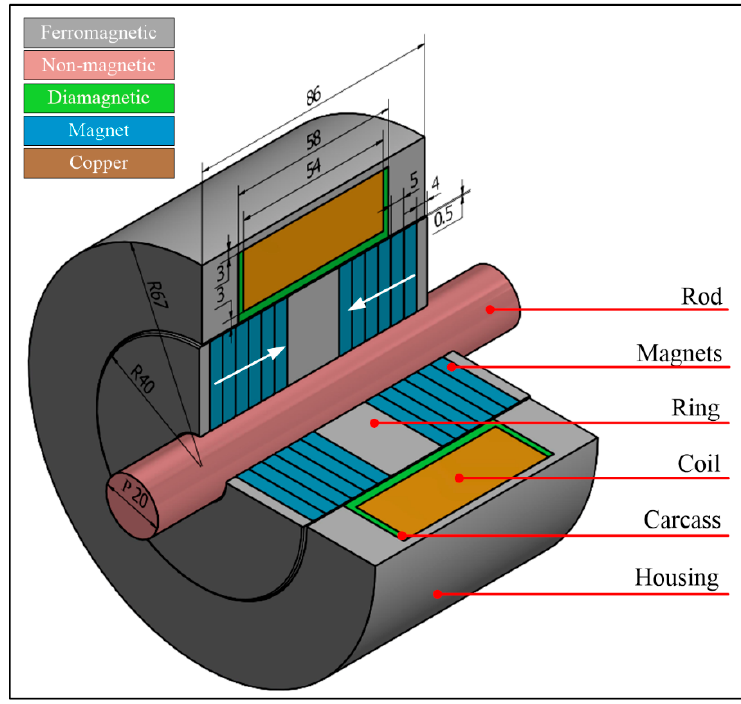
Figure 1. Harvester structure (note: the dimensions are shown in millimetres).